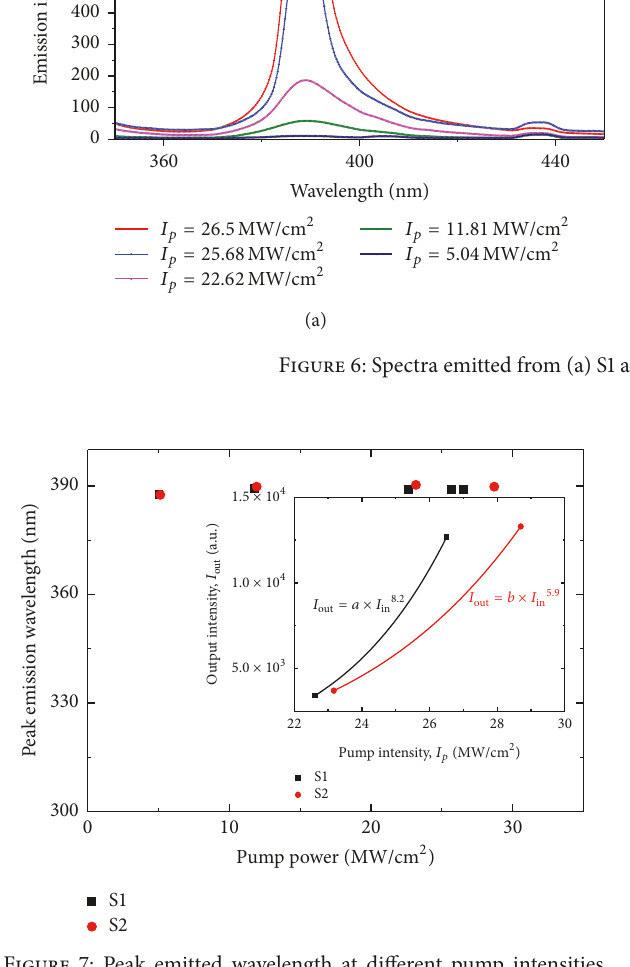
Figure 8: Quantum efficiency at different pump intensities for S1 and